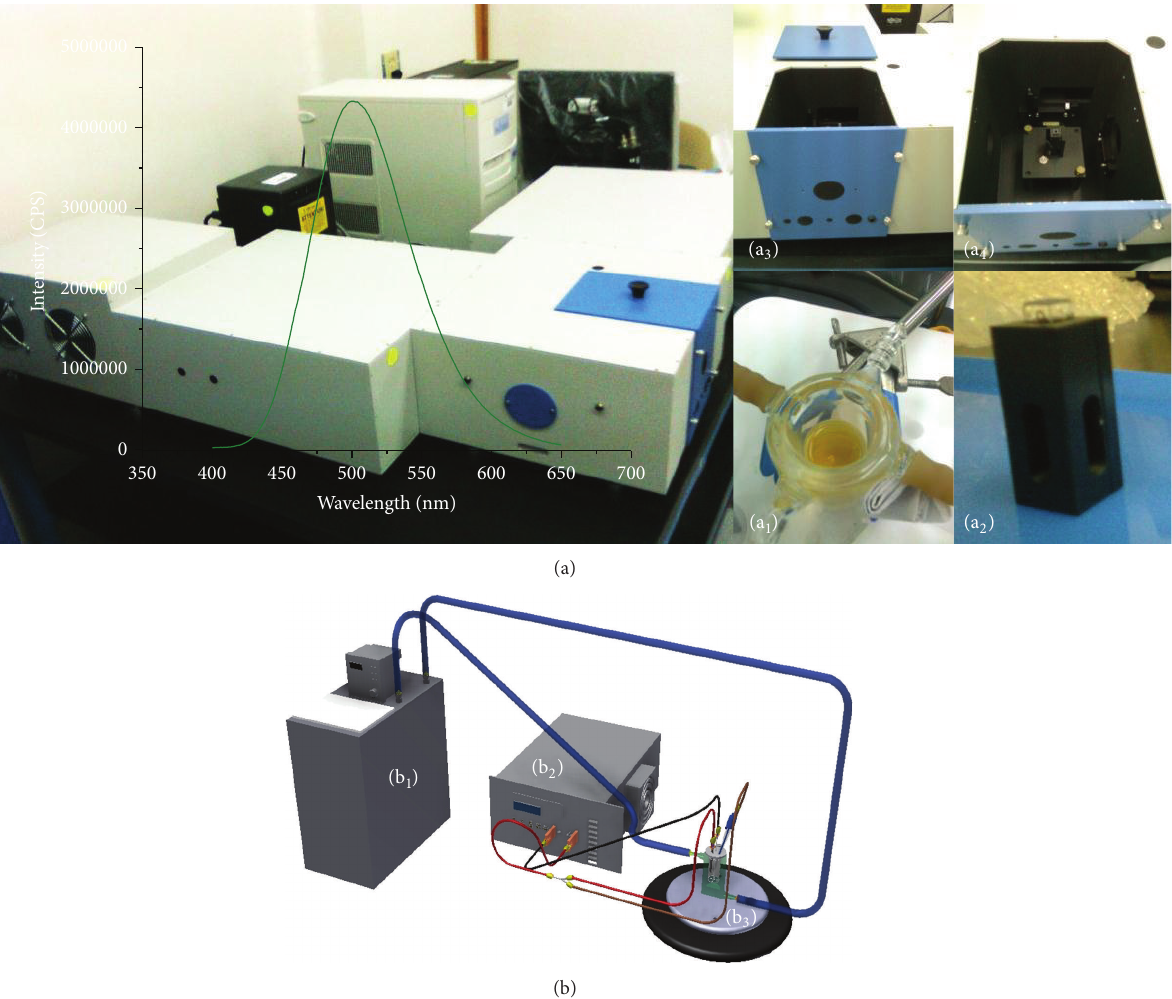
Figure 2: Experimental system for (a) hydroxyl radicals’ analysis by fluorescence spectroscopy, where (a 1 )–(a 4 ) are the steps for analysis of 7-hydroxycoumarin, and (b) electrolysis in galvanostatic mode of spent caustics mixture using Ti/BDD: (b 1 ) heat exchanger, (b 2 ) rectifier, and (b 3 ) electrochemical